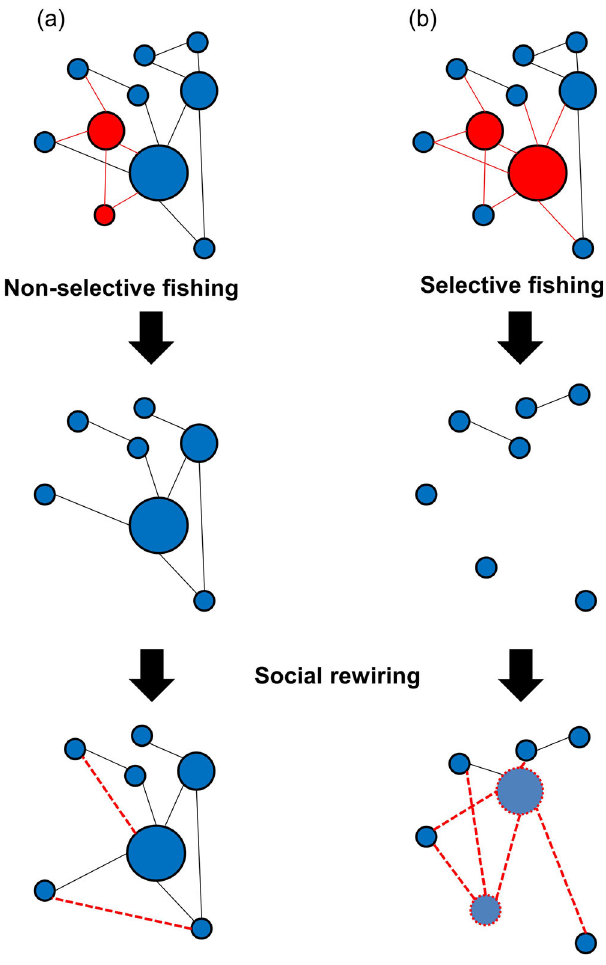
Fig. 4 Fishing effects on fi sh social structure. Through correlations between life-history, behavior, physiology, and social traits, fi shing can range from a non-selective to b highly selective on social network position, with direct effects on the topology of the resulting network and the demography of the populations. Social rewiring dynamics after fi shing will determine if and when the social network can reach an equilibrium state. Red nodes and solid red edges represent individuals, and their associations, removed by the fi shery. Red dashed edges represent newly created associations after the fi shing event. Blue nodes represent non- harvested